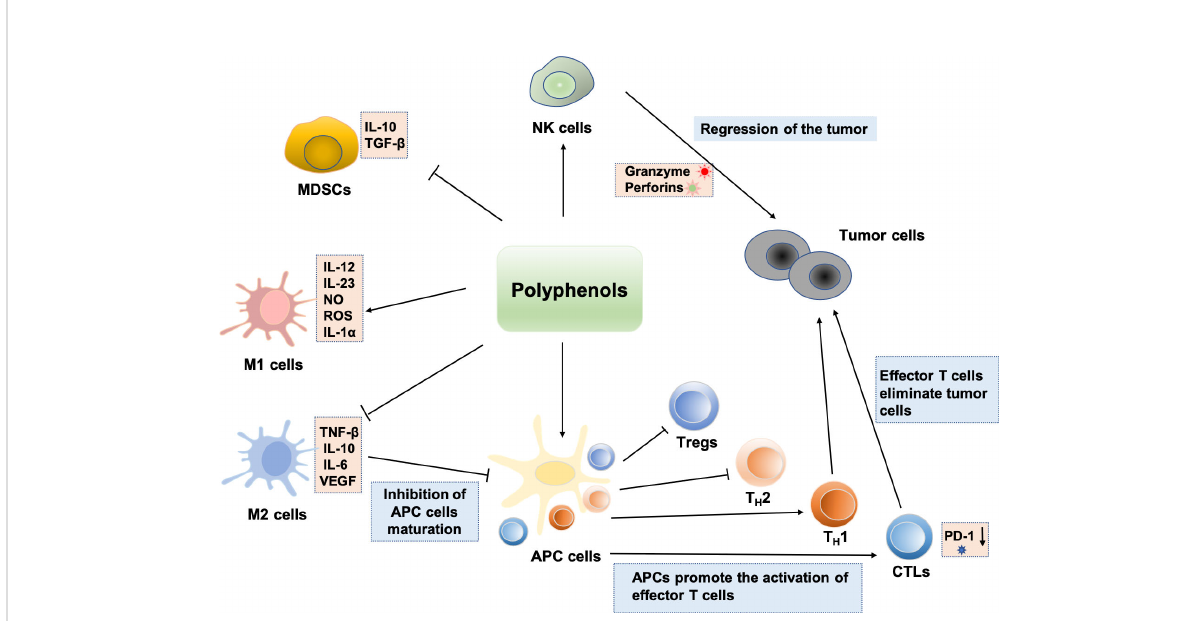
FIGURE 3 Regulation effects of polyphenols on immune cells: polyphenols can enhance NK cell antitumor activity. Some polyphenols can also induce immature MDSCs to differentiate into other mature immune cells. Polyphenols can inhibit the M2-like polarization of TAMs and enhancement the polarization of macrophages toward the M1 phenotype, which exerts antitumor effects. Polyphenols induce immunogenic cell death and induce cellular immunity by activating T H 1 responses. Various polyphenols such as EGCG, genistein, and resveratrol can enhance the number and activities of CTLs. Bisdemethoxycurcumin decreases the level of PD-1 expression on the surface of CD8+ T lymphocytes, thus enhancing the CTLs ’ cytotoxically activity and immune surveillance. In addition, Polyphenols induce tumor immunity by inhibiting the function of Treg and shifting from a T H 2 or Treg balance to a T H 1 response against the tumoral